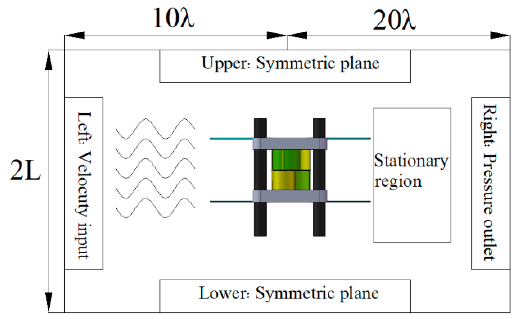
Figure 3. Computational Domain and Boundary Conditions.